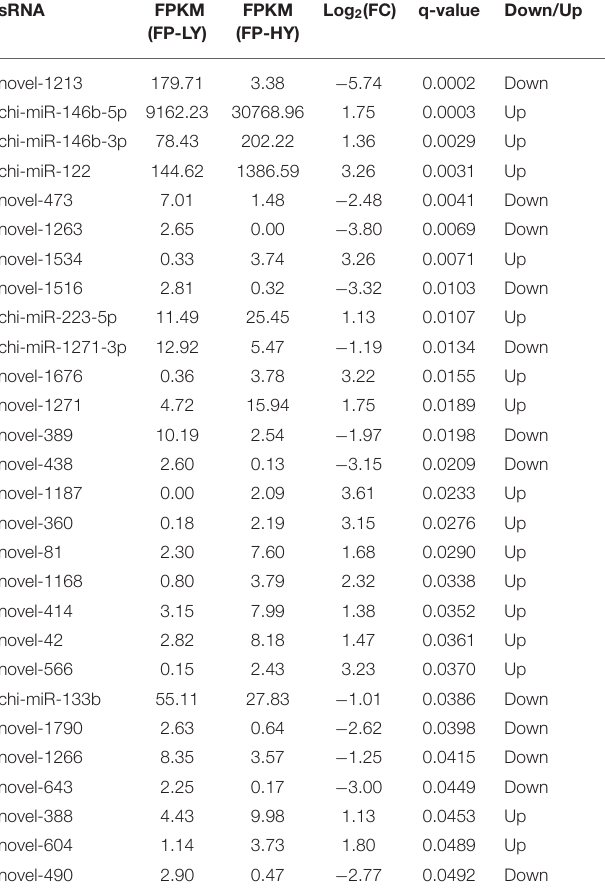
TABLE 2 | 28 DEMs in the hypothalamus of Yunshang black goats between FP-HY and FP-LY. sRNA FPKM FPKM Log 2 (FC) q-value (FP-LY) (FP-HY)